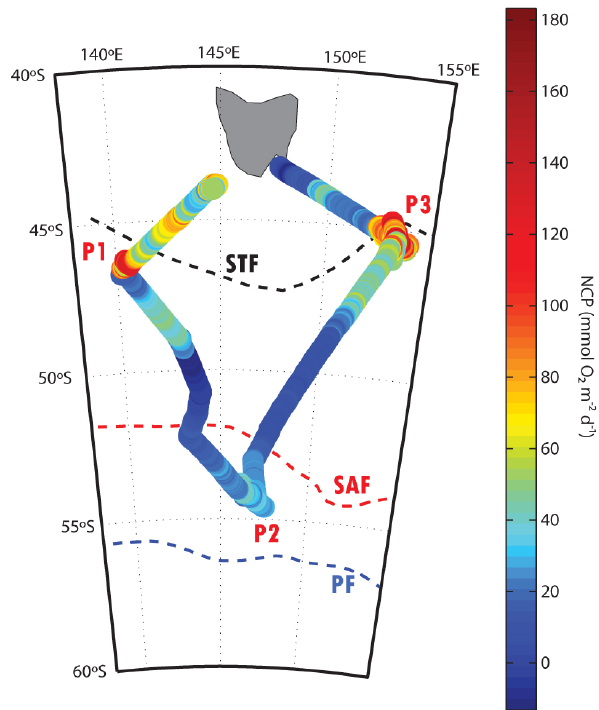
Fig. 1. NCP measurements by EIMS during the SAZ-Sense cruise (mmolO 2 m − 2 d − 1 ). Black, red and blue dashed lines represent the climatological position of the Subtropical (STF), Subantarctic (SAF), and Polar front (PF), based on Orsi et al. (1995). The three process stations are